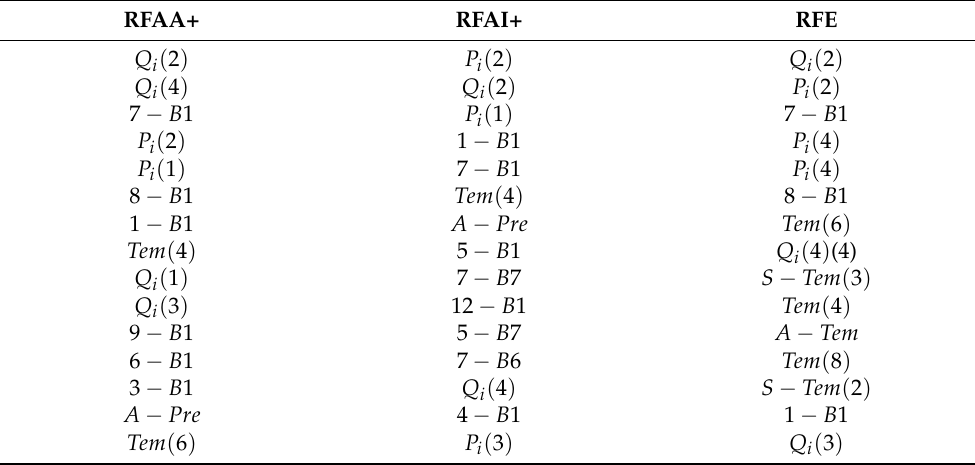
Table 5. Rank the importance of the top 15 indexes generated by different FS methods.